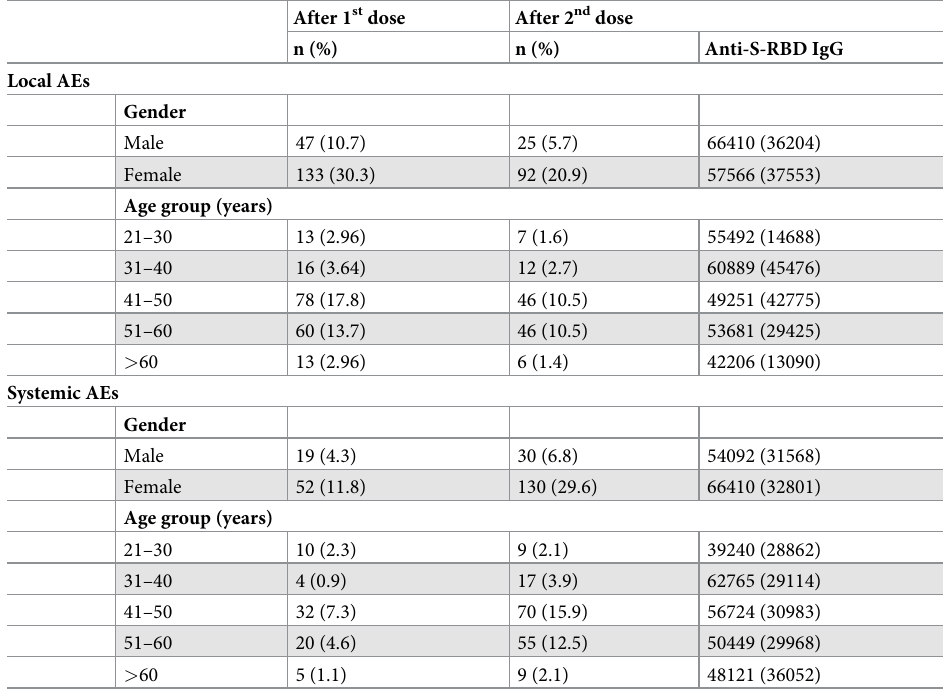
Table 2. Presentation of local and systemic adverse events (AEs) after the first and second dose of BNT162b2 vac- cine and median (IQR) SARS-CoV-2 anti-S-RBD antibody titers 3–4 weeks after the second dose (first period) in the study population (n =